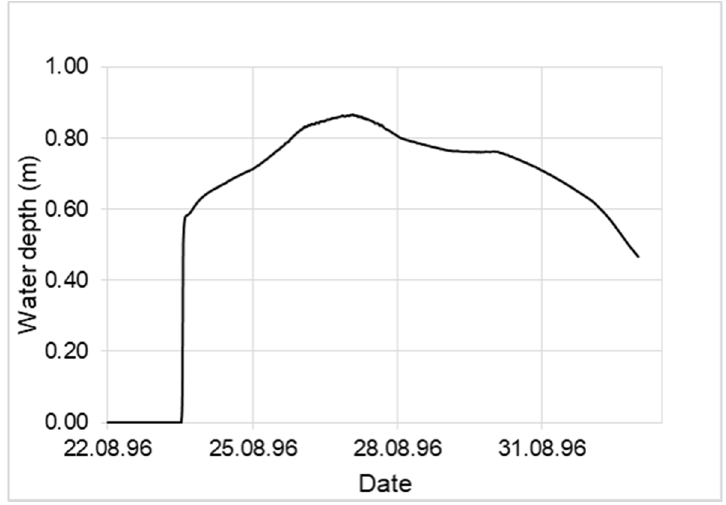
Figure 7. Model validation: Modelled water depth at the office location corresponding to the breach information.